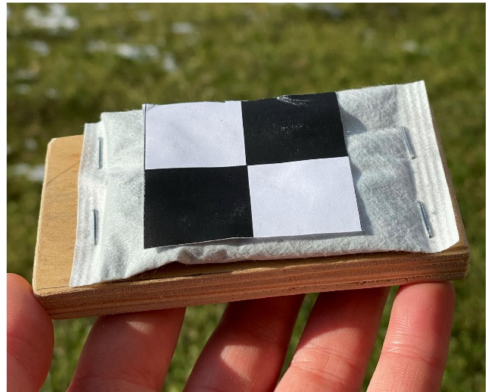
Figure 2. Preparation of the thermovision